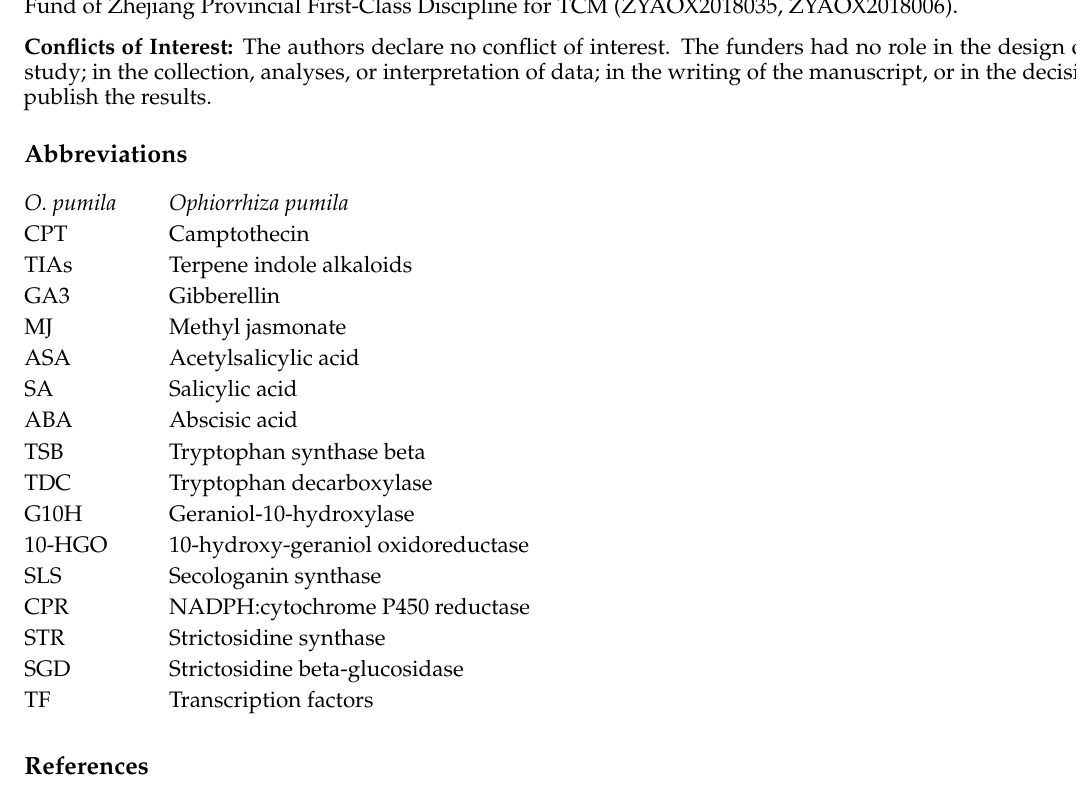
HPLC. Figure S5: Camptothecin biosynthetic pathway in O. pumila . Figure S6: Expression vectors construction for transformation. Figure S7: Analysis of Tryptamine, Loganin, Secologanin and CPT standard by HPLC. Table S1: Oligonucleotide primers used in this